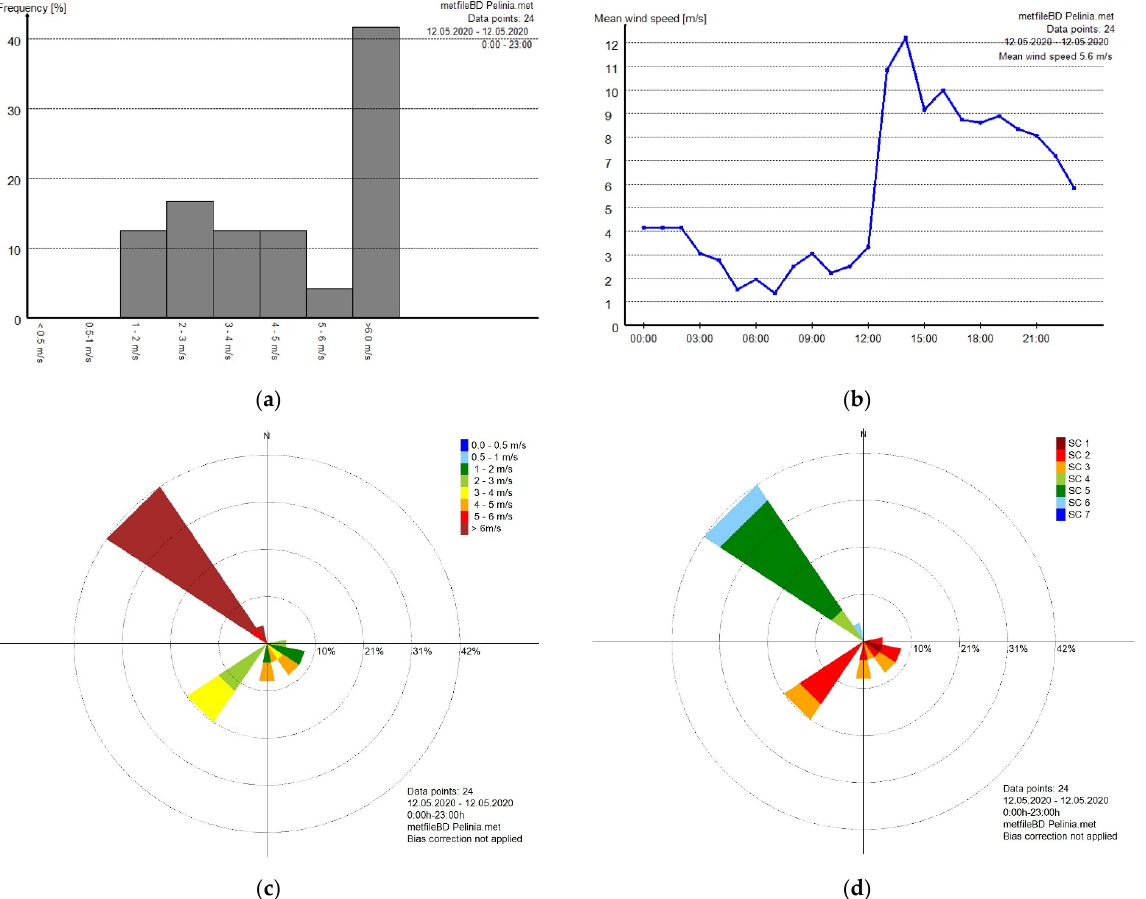
Figure 4. Meteorological parameters for Pelinia village, Republic of Moldova, on 12 May 2020: ( a ) frequency of wind intensity; ( b ) hourly frequency of wind intensity; ( c ) wind rose; ( d ) stability of wind